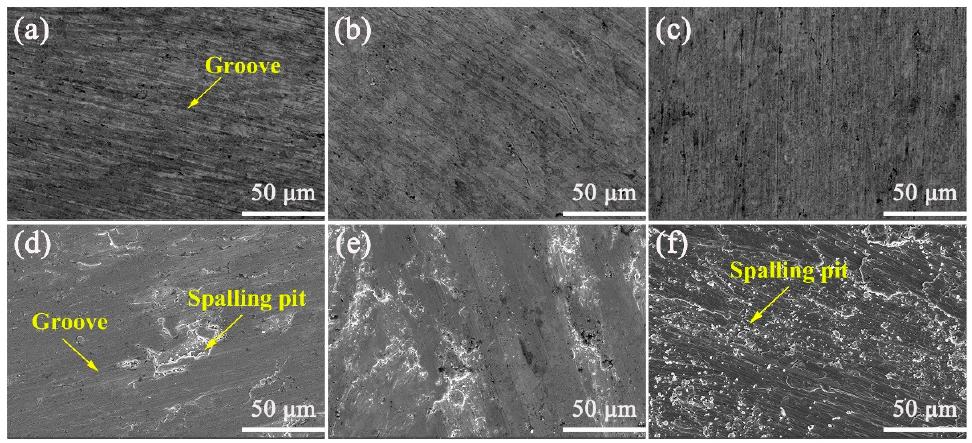
Figure 13. SEM micrographs of the worn surface: ( a ) S1, ( b ) S2, ( c ) S3, ( d ) S4, ( e ) S5 and ( f ) S6.